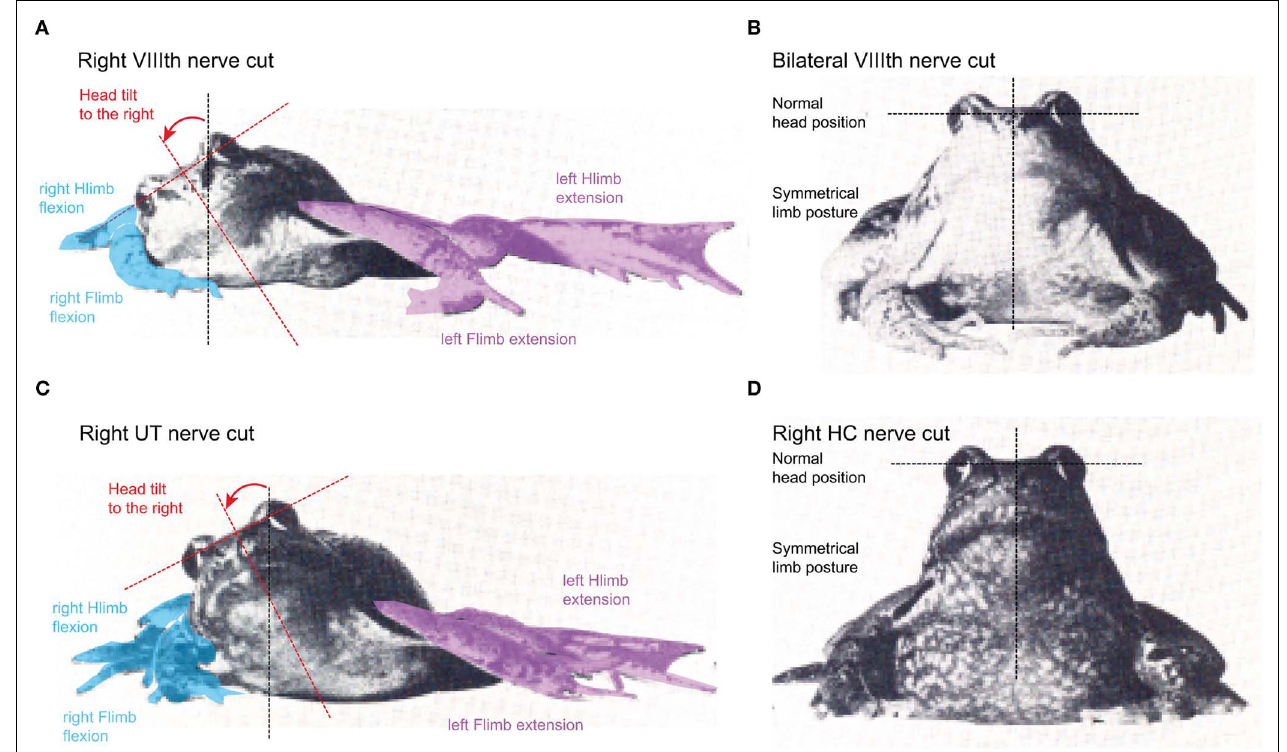
(UT) nerve branch on the right side (C) ; absence of postural deficits after a bilateral section of theVIIIth nerve (B) or of one horizontal semicircular canal nerve (D) . Hlimb, hindlimb; Flimb, forelimb. Modified and adapted from Precht and Dieringer